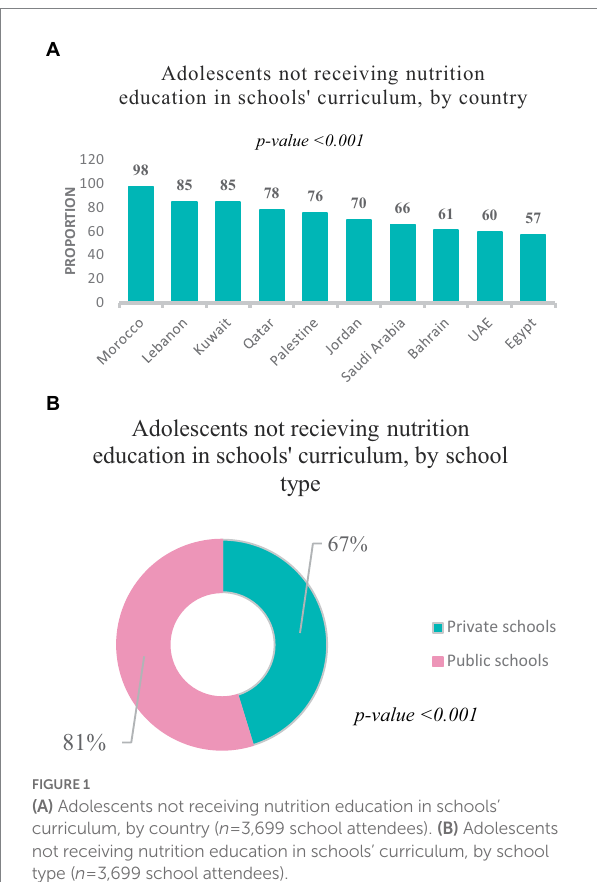
FIGURE 1 (A) Adolescents not receiving nutrition education in schools’ curriculum, by country ( n = 3,699 school attendees). (B) Adolescents not receiving nutrition education in schools’ curriculum, by school type ( n = 3,699 school